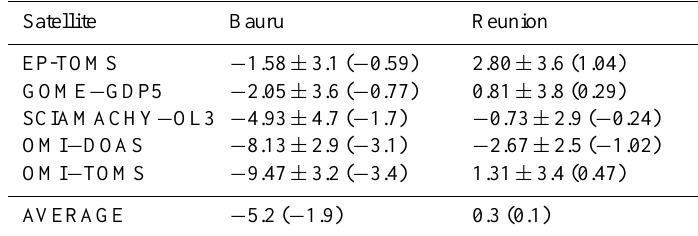
Table 1. Mean biases and standard deviation in DU (%) between satellites and SAOZ total